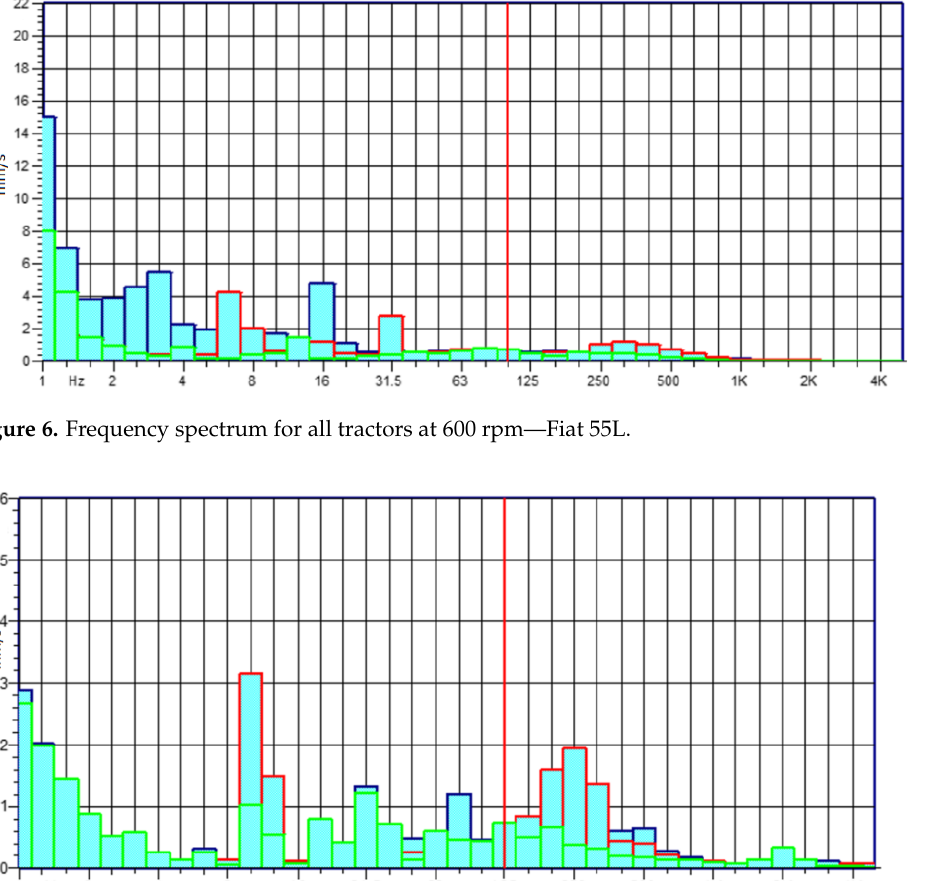
Figure 5. Comparison of time history for all tractors at 1000 rpm.